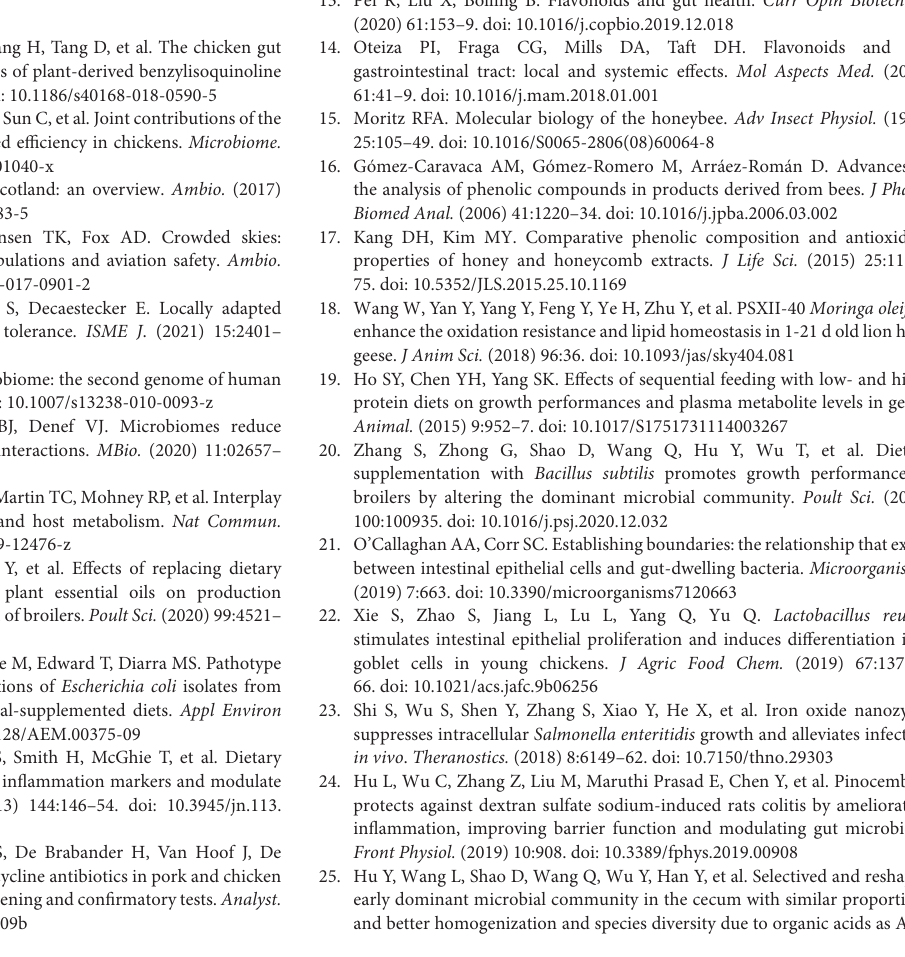
Supplementary Table 1 | Taxonomy results of cecal microbiota in both control and HF supplement